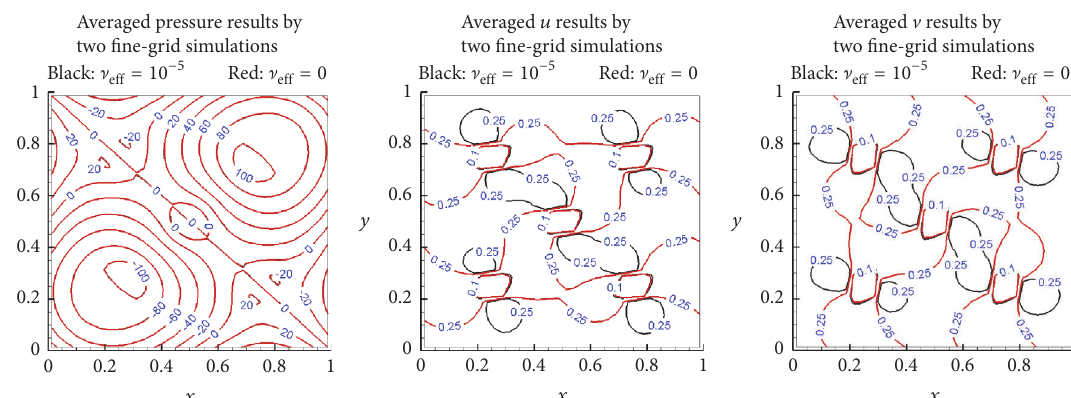
⃗𝐺 = ( sin 𝜋𝑥, sin 𝜋𝑦) m s −2 ,